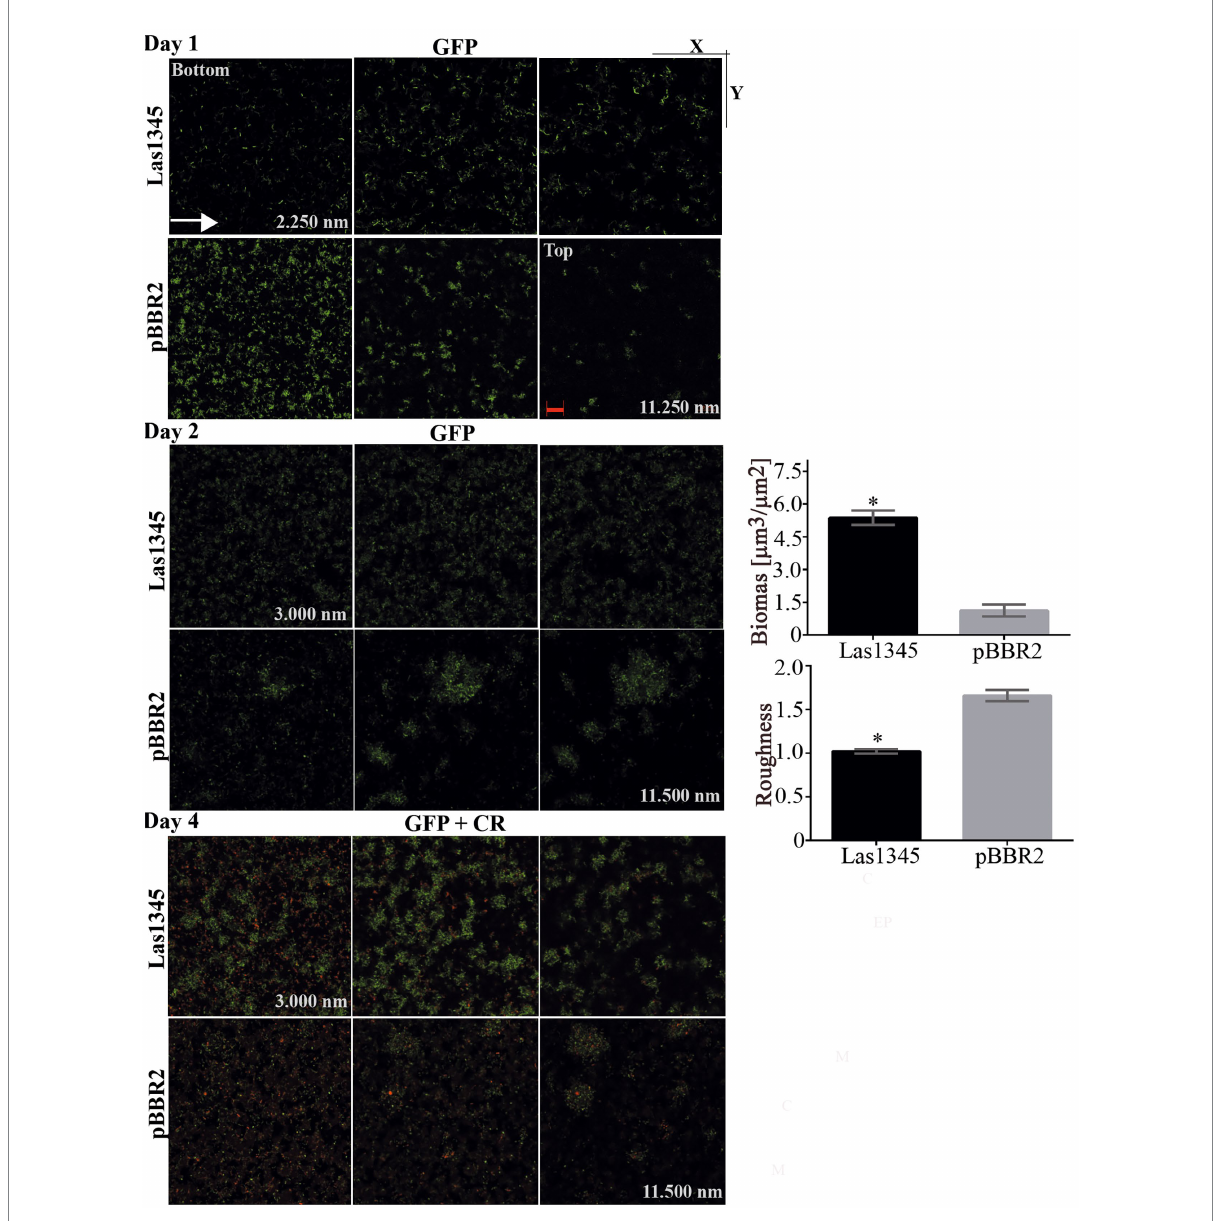
FIGURE 6 Biofilm architecture of Xanthomonas campestris pv . campestris ( Xcc ) is disrupted when Las1345 is expressed. GFP-labeled Xcc cells ( Xcc -GFP) expressing Las1345 ( Xcc -GFP/Las1345) were grown in 8-well chambers with a 1-mm thick borosilicate glass containing Y minimal medium and visualized at different stages of biofilm formation under confocal laser scanning microscopy for 4 days after inoculation at 28 ° C. Biofilm structure is shown as 2D-images of a single layer in the XY plane at different distances from the bottom well along the Z-axis (0–11898.21 nm) at day 1, 2 and 4. Green channel shows Xcc -GFP/Las1345 (Las1345) or Xcc -GFP/pBBR2 (pBBR2) cells. At day 1, a detail (right corner) of the biofilm structure in Xcc -GFP/Las1345 and control cells is shown. At Day 2, Biomass and Roughness coefficient using COMSTAT 2.0 were calculated. Data is shown as means ± standard deviation of three replicates. Asterisks indicate significant differences at p < 0.05 (Student’s t -test). At day 4, biofilm structure is showed by GFP (green channel) and Congo red (CR) emission (red channel) to indicate cells and exopolysaccharides production in the extracellular matrix, respectively. A detail of the biofilm structures is shown for both strains. C, GFP cells; EPS, exopolysaccharide; M, extracellular matrix. Scale bars, 20 μ